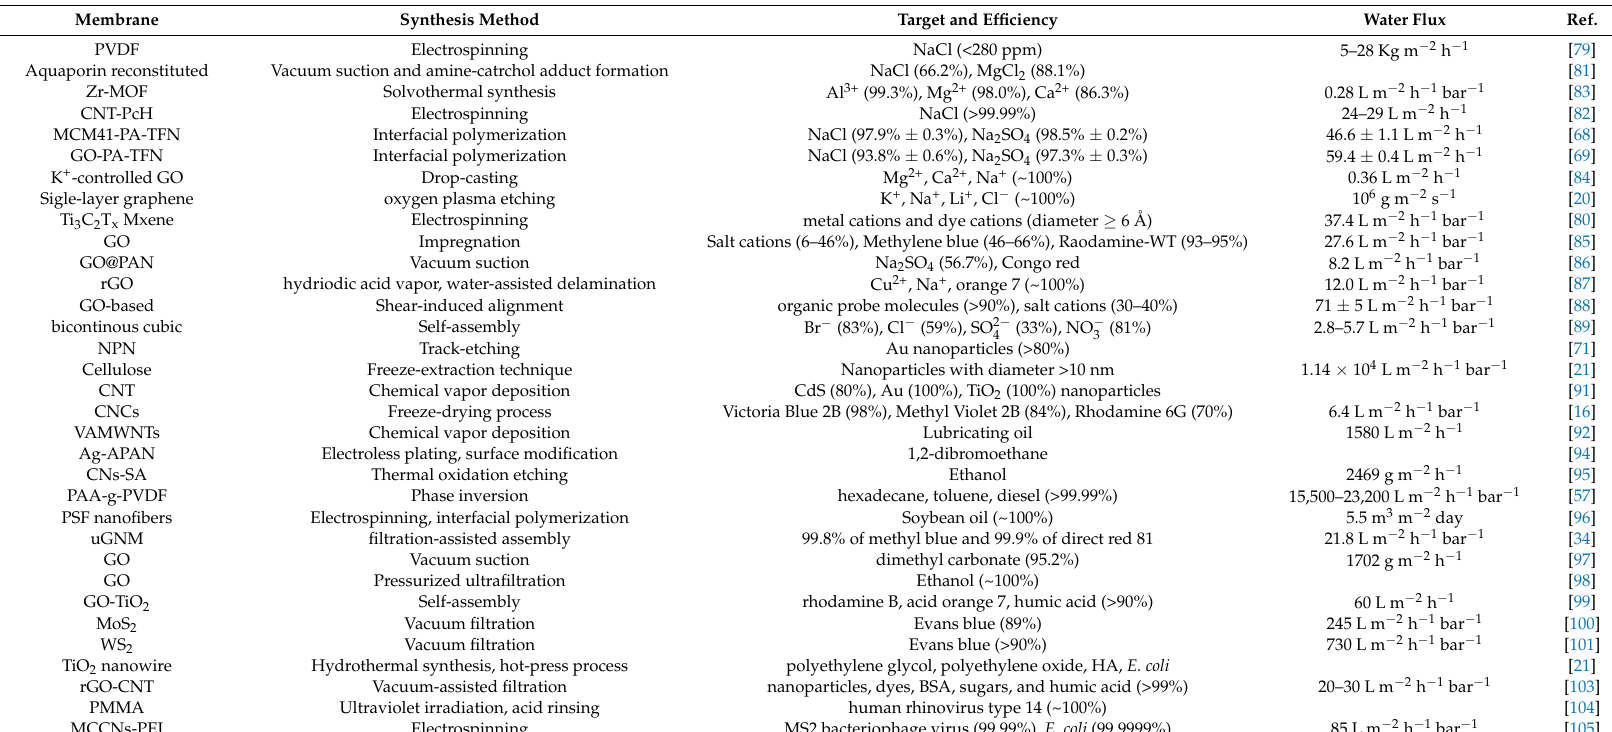
Table 1. Application examples of nanoporous membranes for water purification a